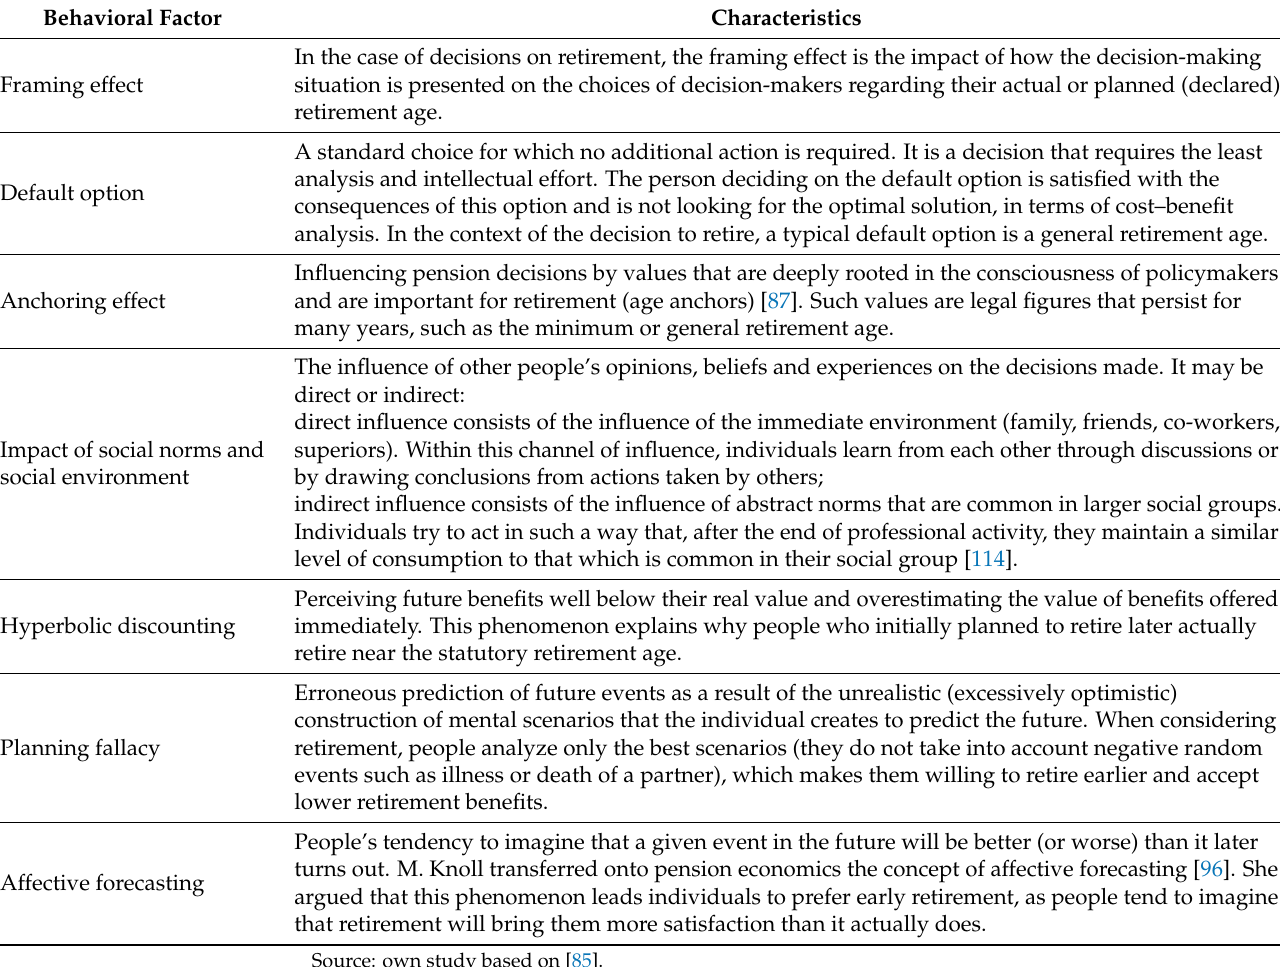
Table 1. Behavioral Factors Affecting Retirement